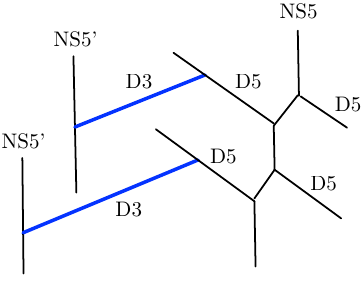
Figure 21 . The new brane web matches with the vortex partition function